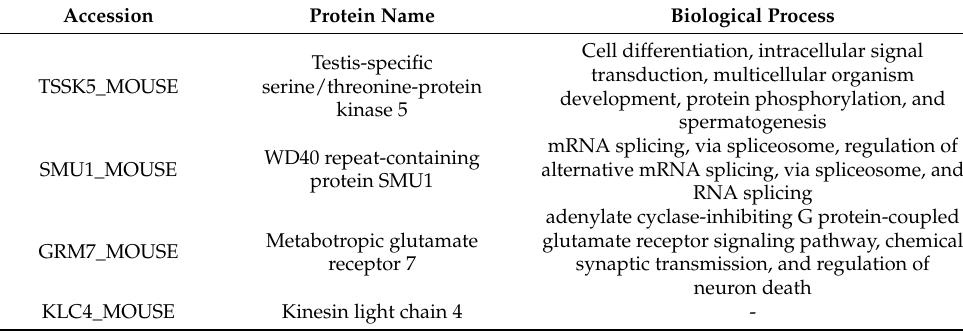
Table 3: The description and functions of the top 4 significant proteins uniquely identified in the liposome-encapsulated hydrolysate treatment group. This information was obtained from the UniProtKB database.